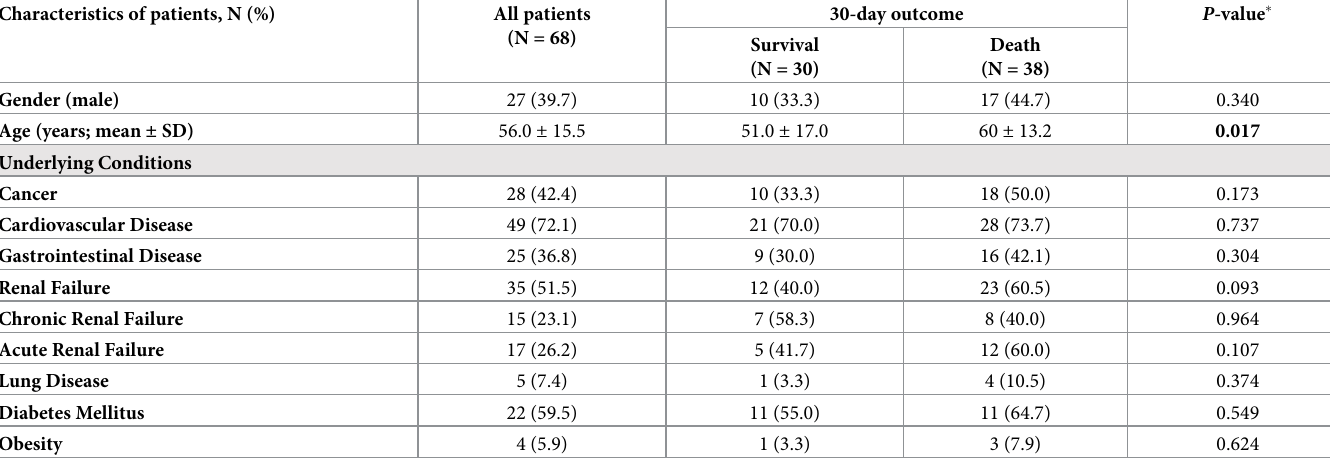
Table 1. Demographic characteristics and underlying conditions of patients with candidemia, including comparison between subgroups according to the outcome. Characteristics of patients, N